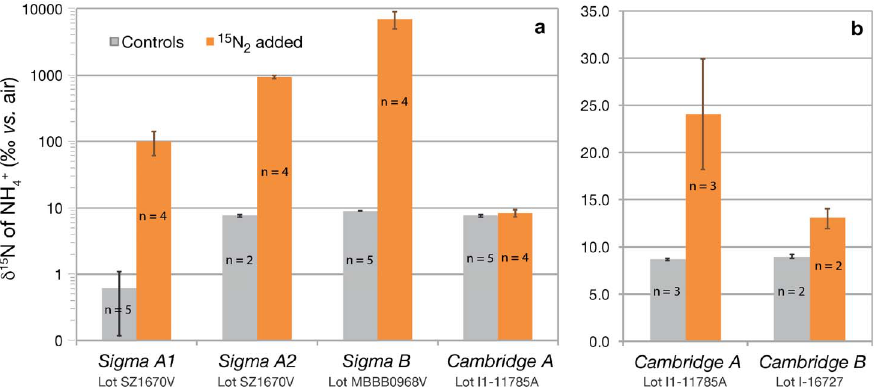
Figure 3. (a) d 15 N NH4 (log scale) of 5 m mol L 2 1 ammonium solutions after equilibration with 0.1 mL 15 N 2 gas from respective Sigma- Aldrich and Cambridge Isotopes lecture bottles vs. control solutions. Sigma-Aldrich treatments utilized 40 mL ammonium solutions, whereas Cambridge Isotopes treatments utilized 100 mL ammonium solutions. ( b ) d 15 N NH4 of higher sensitivity equilibrations of 5 m mol L 2 1 ammonium solutions (10 mL) with 2.0 mL 15 N 2 gas from Cambridge Isotopes lecture bottles vs. control solutions. n=the number of experimental replicates.